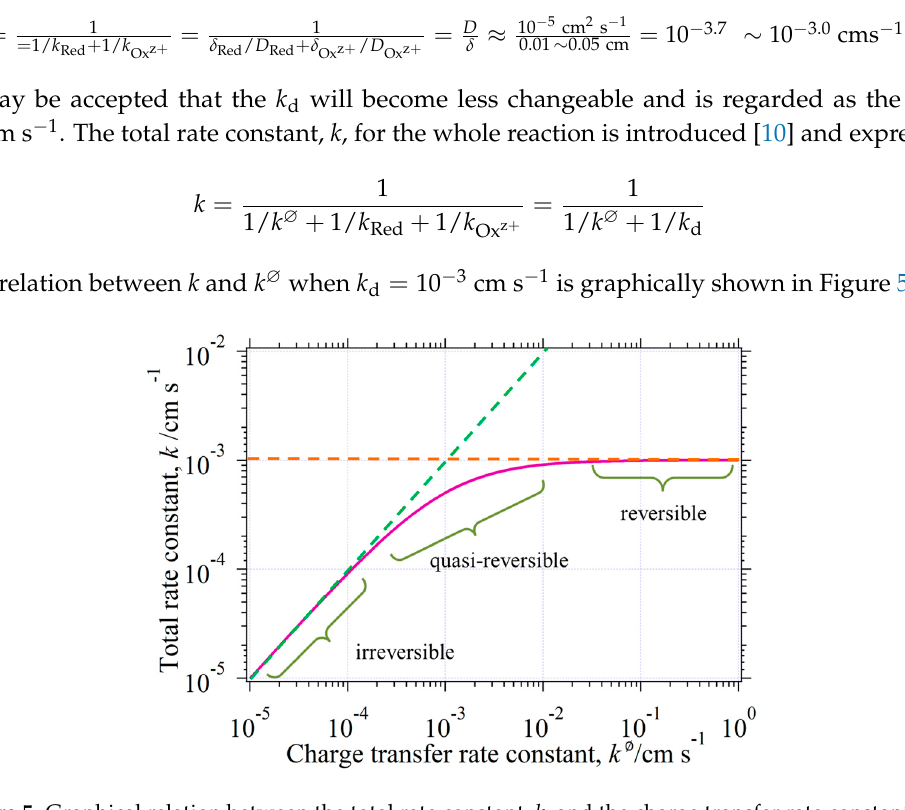
Figure 5. Graphical relation between the total rate constant, k, and the charge transfer rate constant, k ∅ , when the diffusion rate is a constant of k d = 10 − 3 cm s − 1